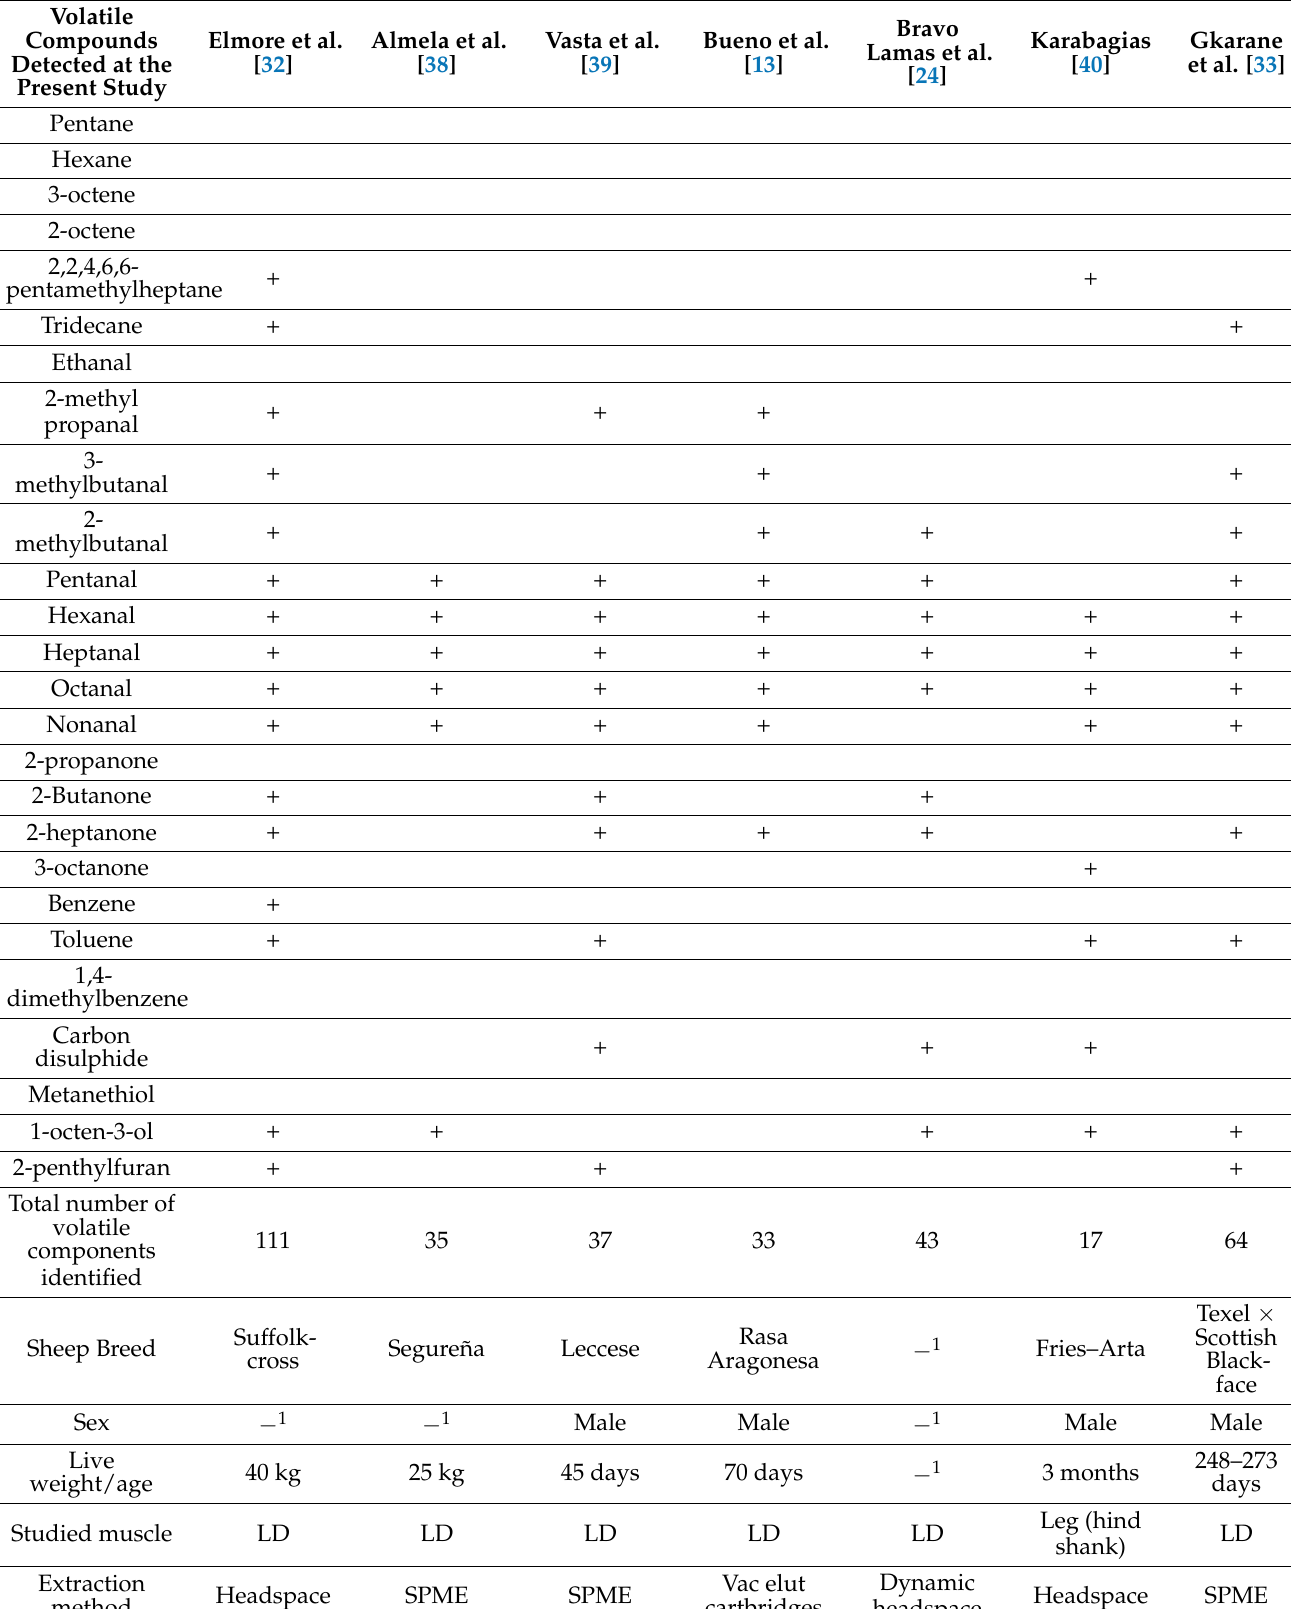
Table 2. Review of volatile compounds in lamb